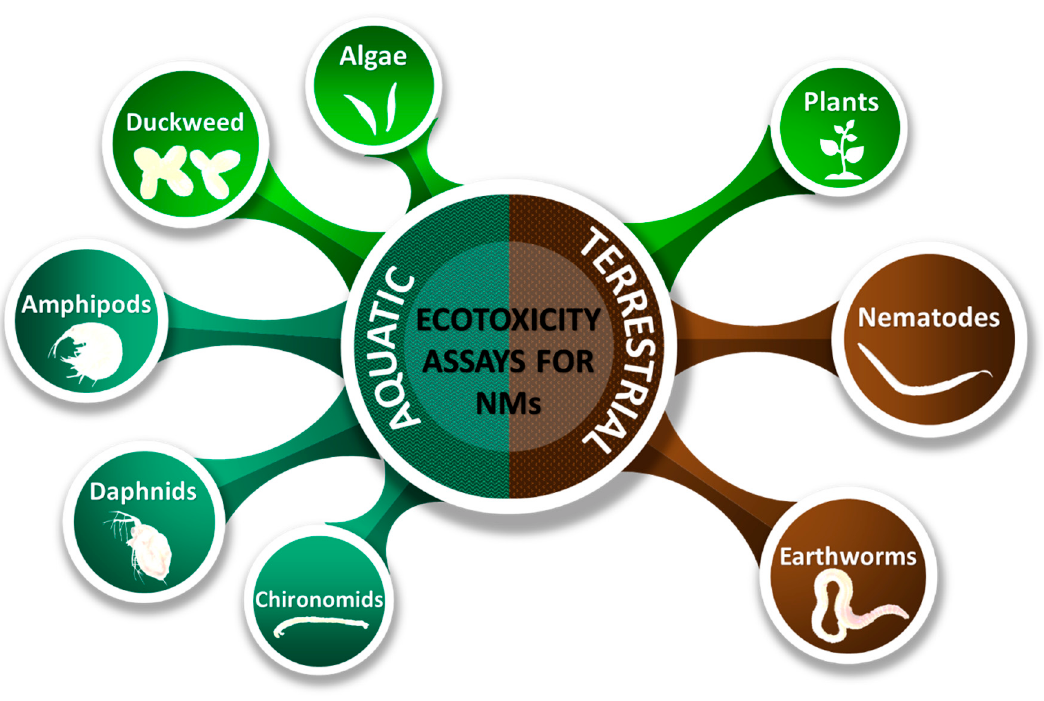
Figure 7. Standard assays selected to be adaptable for NMs.